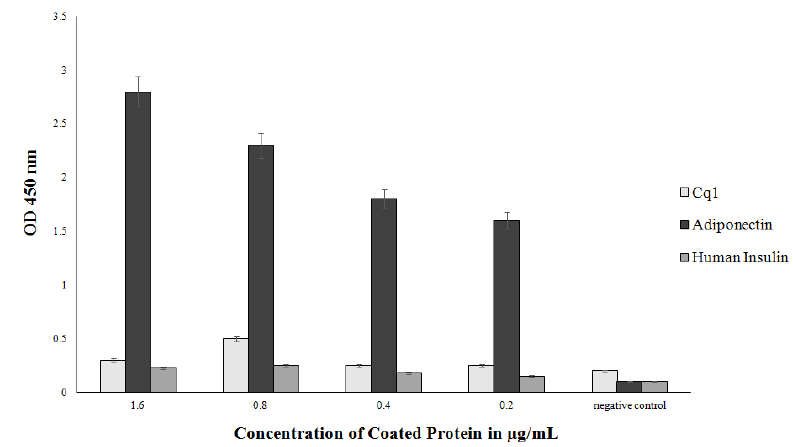
Figure 6. Sensitivity and Specificity of scFvH5. Sensitivity and specificity of scFvH5 were verified by ELISA using 0.1 µg/mL of scFvH5. In addition to the coated recombinant adiponectin, protein Cq1 and human insulin were used for determining the specificity, while the different amounts of the coated proteins were used for determining the sensitivity of scFvH5. The ELISA results are given as mean ± SD values from triple determinations. Insulin was used as a general negative control.